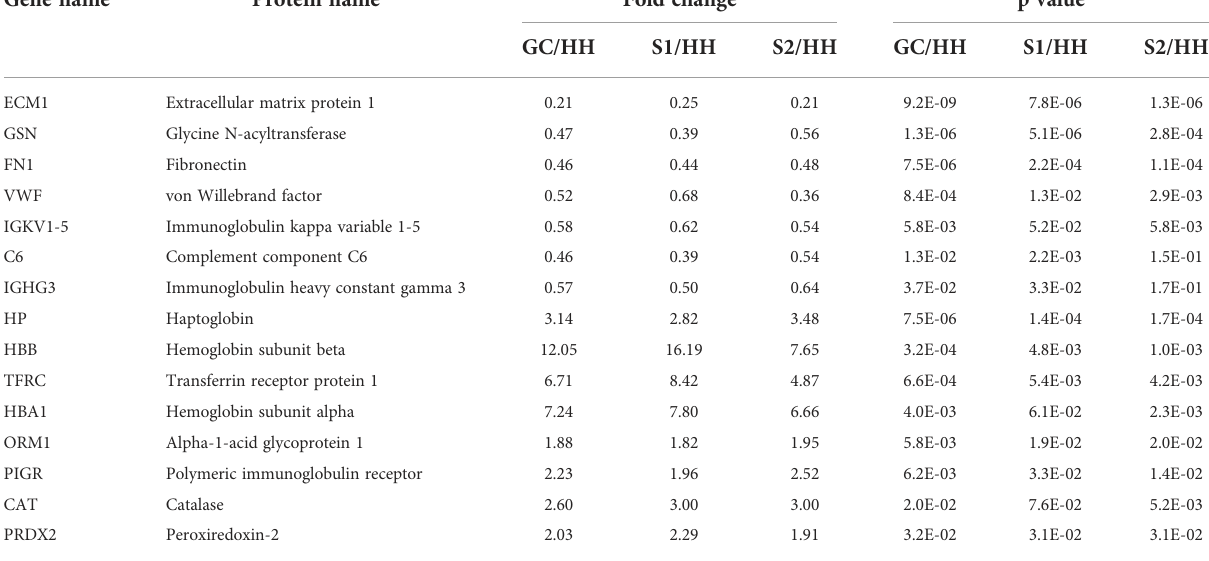
TABLE 2 Expression data of 15 candidate protein